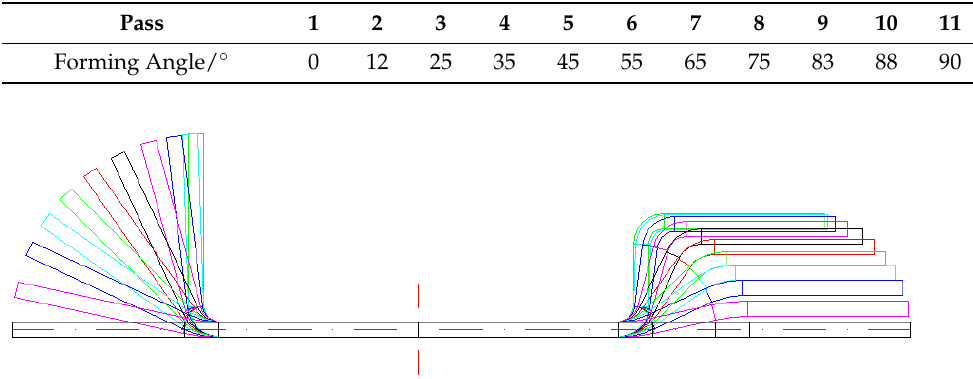
Figure 4. Automobile lower beam forming, roller flower drawing.